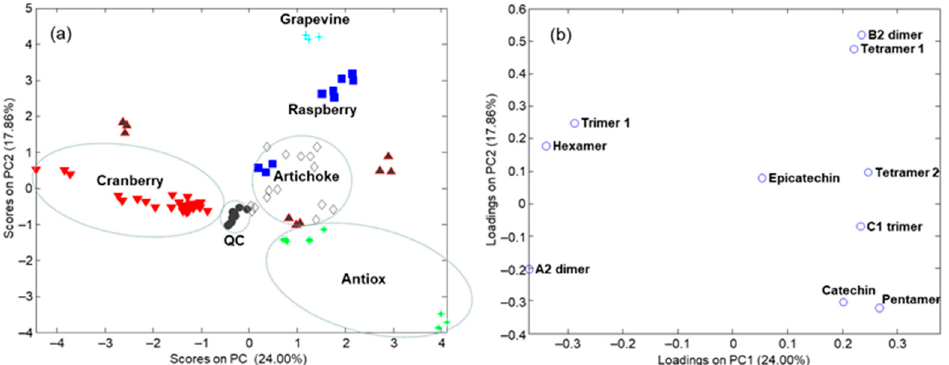
Figure 3. Characterization of nutraceuticals and dietary supplements by principal component analysis (PCA) using the compositional profiles of flavanols as the data. ( a ) Scatter plot of scores of PC1 vs. PC2; ( b ) scatter plot of loadings of PC1 vs. PC2. Sample assignation: triangle ( vertex down ) = cranberry; triangle ( vertex up ) = red grape; rhombus = artichoke; cross = grapevine; square = raspberry; asterisk = antiox and circle = QCs.